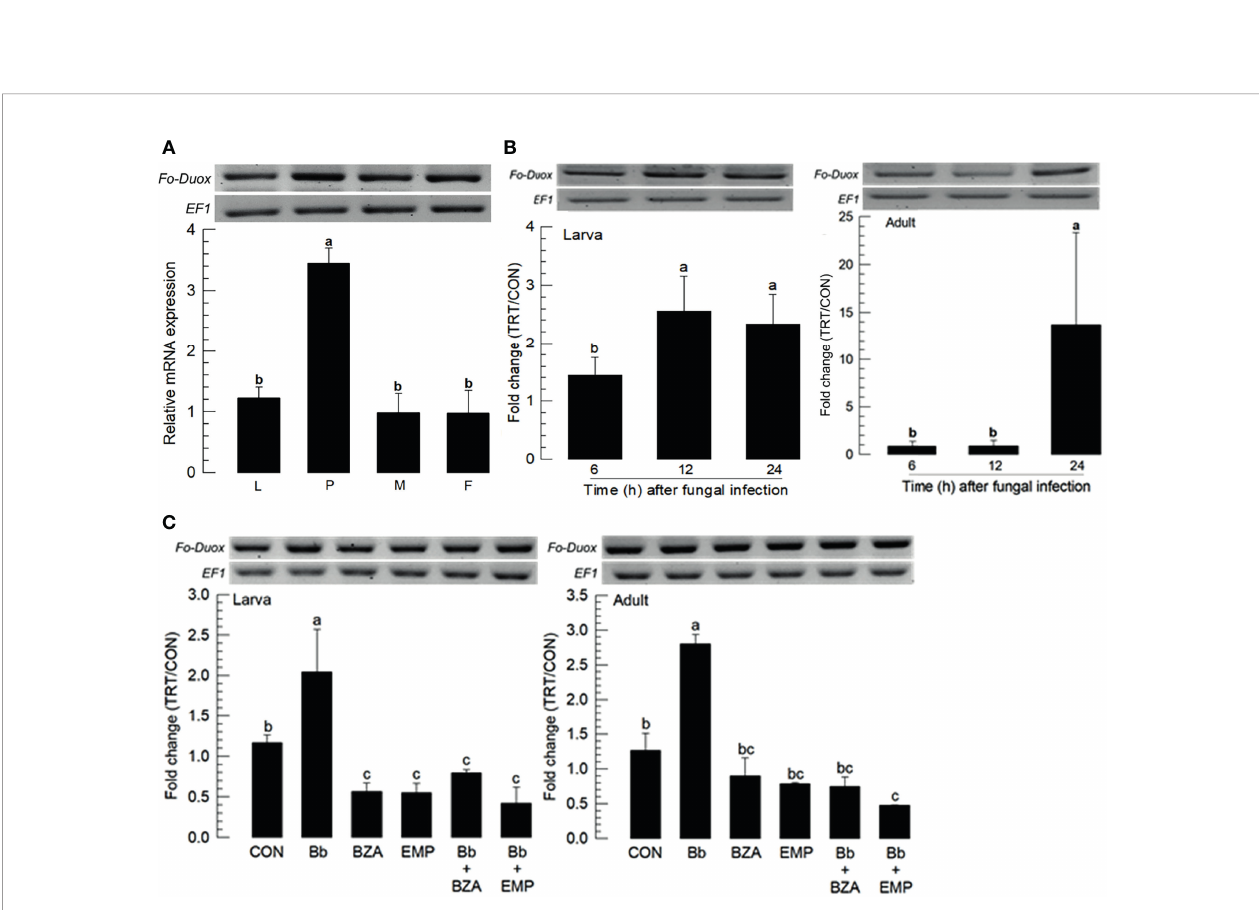
FIGURE 6 | Inducible expression of dual oxidase (Duox) in F. occidentalis ( Fo-Duox ) upon fungal challenge. (A) Expression levels of Fo-Duox in different developmental stages of larva ( ‘ L ’ ), pupa ( ‘ P ’ ), male ( ‘ M ’ ), and female ( ‘ F ’ ) adult. RNA samples were collected from the whole body extracts of larvae (~100), pupae (~100), or adults (~100) for each treatment. (B) Inducible expression of Fo-Duox in L2 larvae or adults upon fungal challenge with B. bassiana (1×10 6 conidia/mL) at different time points. RNA samples were collected from the whole body extracts of larvae (~100) or adults (~100) for each treatment. (C) Inhibitory effects of EMP or BZA on the expression of Fo-Duox in larvae or adults. To check this immunosuppressive activity, B. bassiana (1×10 5 conidia/mL) along with EMP (1,000 ppm) or BZA (1,000 ppm) were used as mentioned previously. RNA samples were collected from the whole body extracts of larvae (~100) or adults (~100) for each treatment at 24 h post-infection. The expression of an endogenous gene, EF1 , con fi rms equal gel loading and integrity of cDNA preparation. Each measurement was replicated three times. Fold changes are calculated by ratios of expression levels of immune-challenges ( ‘ TRT ’ ) over naïve ( ‘ CON ’ ) thrips. Different letters above standard deviation bars indicate signi fi cant differences among means at Type I error = 0.05 (LSD test).